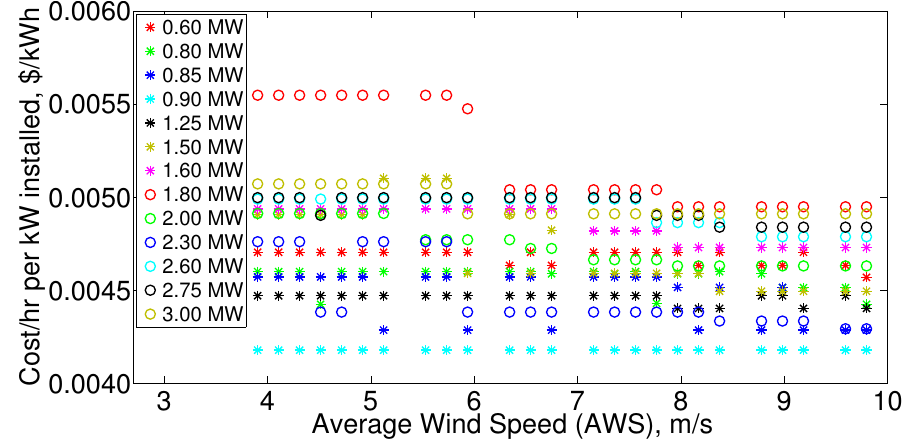
Figure 8. The cost/hr per kW installed given by the best performing turbines (of each rated-power class) for each sample